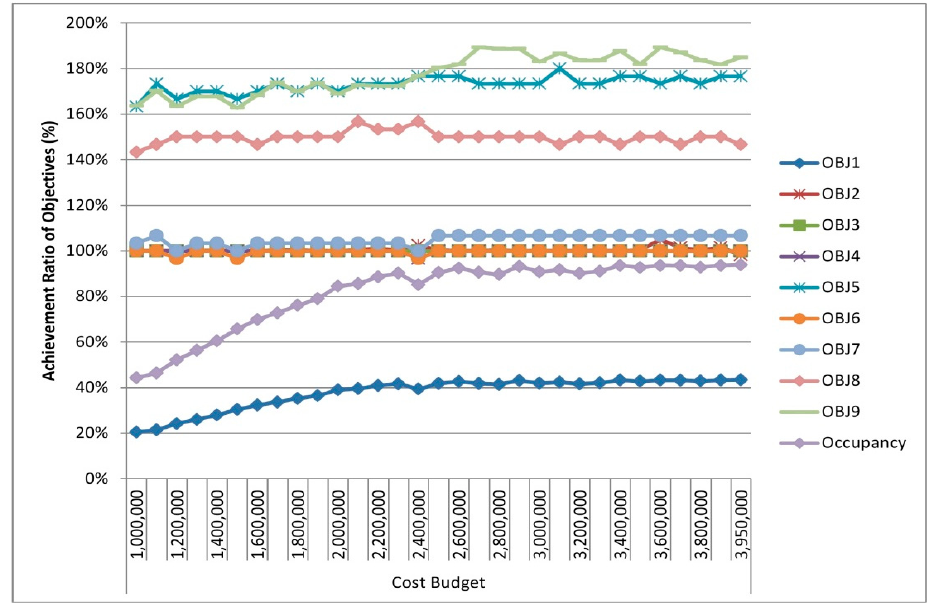
Figure 8. Achievement ratios of objectives acquired as a result of conducting sensitivity analyses regarding the cost budget. Int. J. Environ. Res. Public Health 2019 , 16 , x